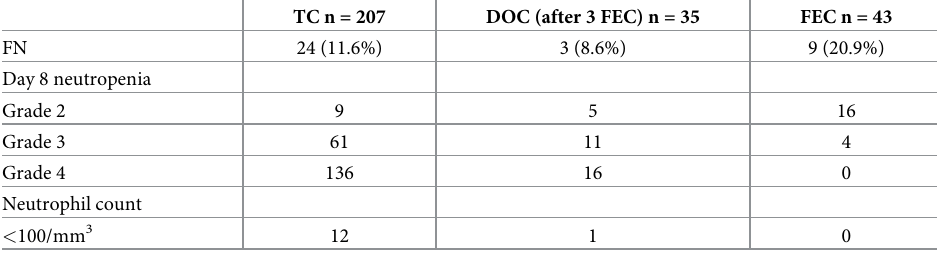
Table 2. Occurrence of febrile neutropenia and neutropenia grade on day 8.